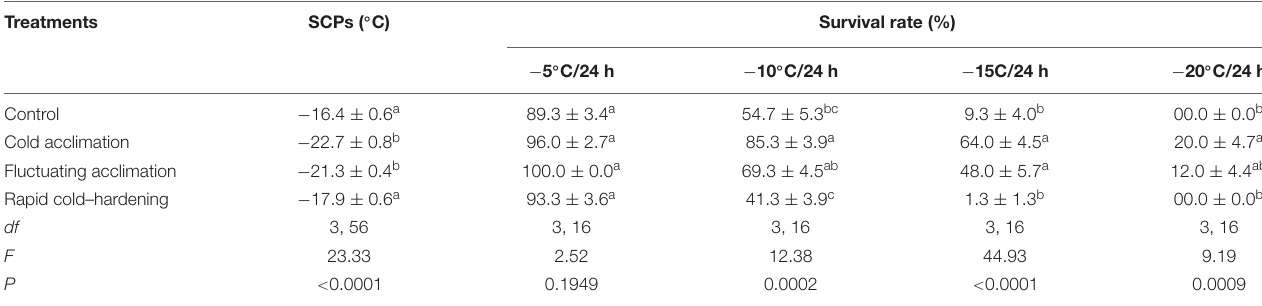
TABLE 2 | Relationship between low temperature survival rate ( n = 5) and supercooling points ( n = 15) of Trogoderma granarium fourth instar larvae following different thermal regimes.